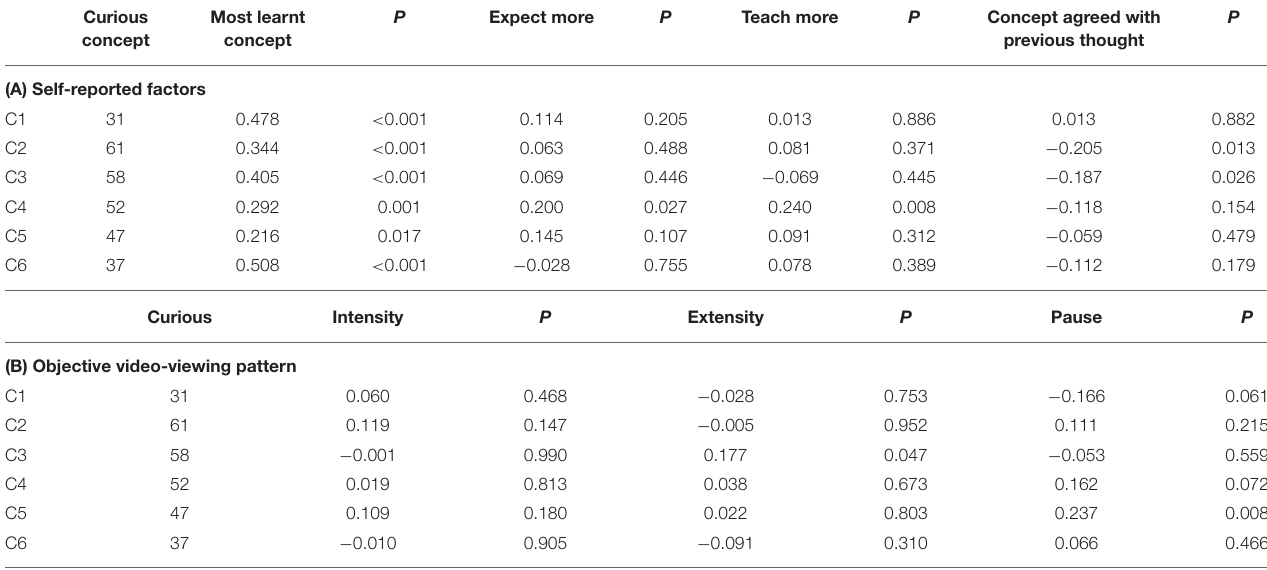
TABLE 2 | Kendall’s Tau-B correlation coefficient of curiosity with other